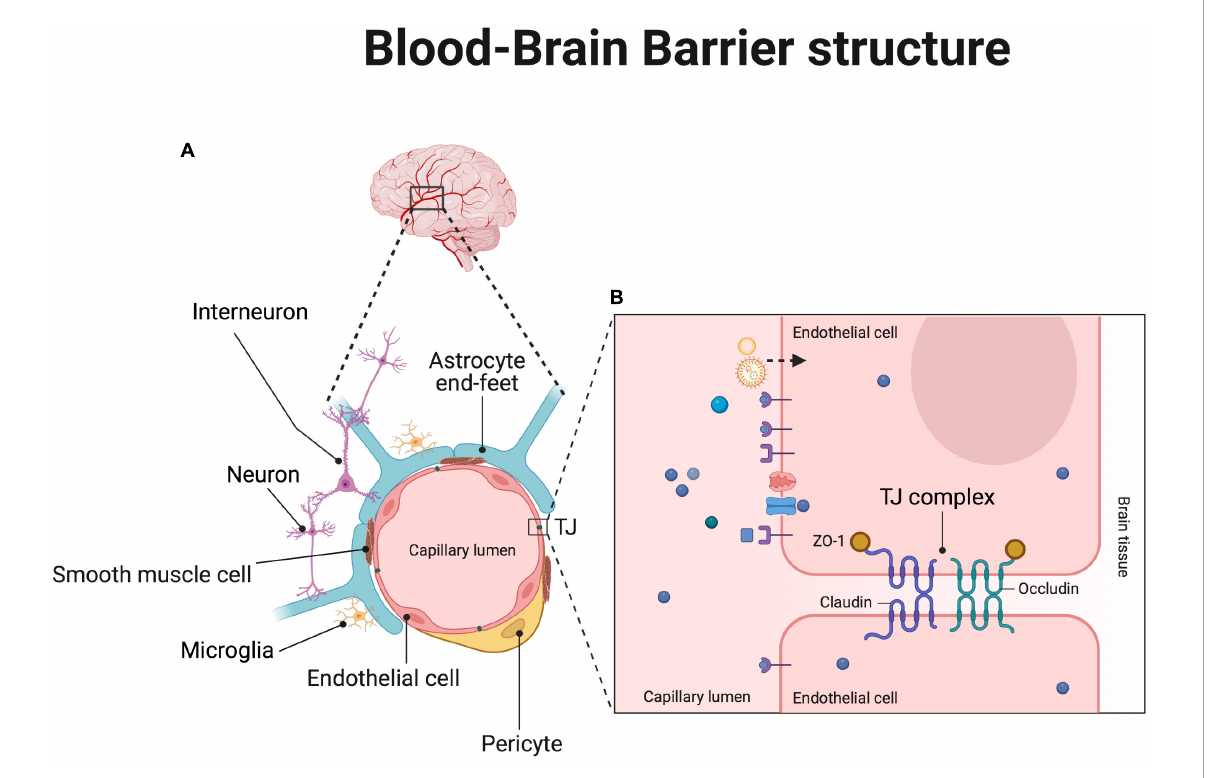
FIGURE2 Schematic representation of the BBB structure and possible drug delivery pathways. (A) Blood vessels of the human brain and, down below, magnified square inset of a vessel cross section showing the different cell components that surround and ensheath the endothelium surface made of a monolayer of endothelial cells sealed by tight junction (TJ) complexes (enlarged in panel B). In the enlarged box in (B) are schematized passive (dashed black arrow and micelles or lipid NPs) and active (violet receptors as well as pink and blue transporters and channels through the endothelial cell membrane) transport mechanisms of different molecules, ligands and NPs (depicted with different colors) across the endothelial cells of the BBB mediated by surface receptors, channels and transporters as further detailed in Figure 3 . Created with